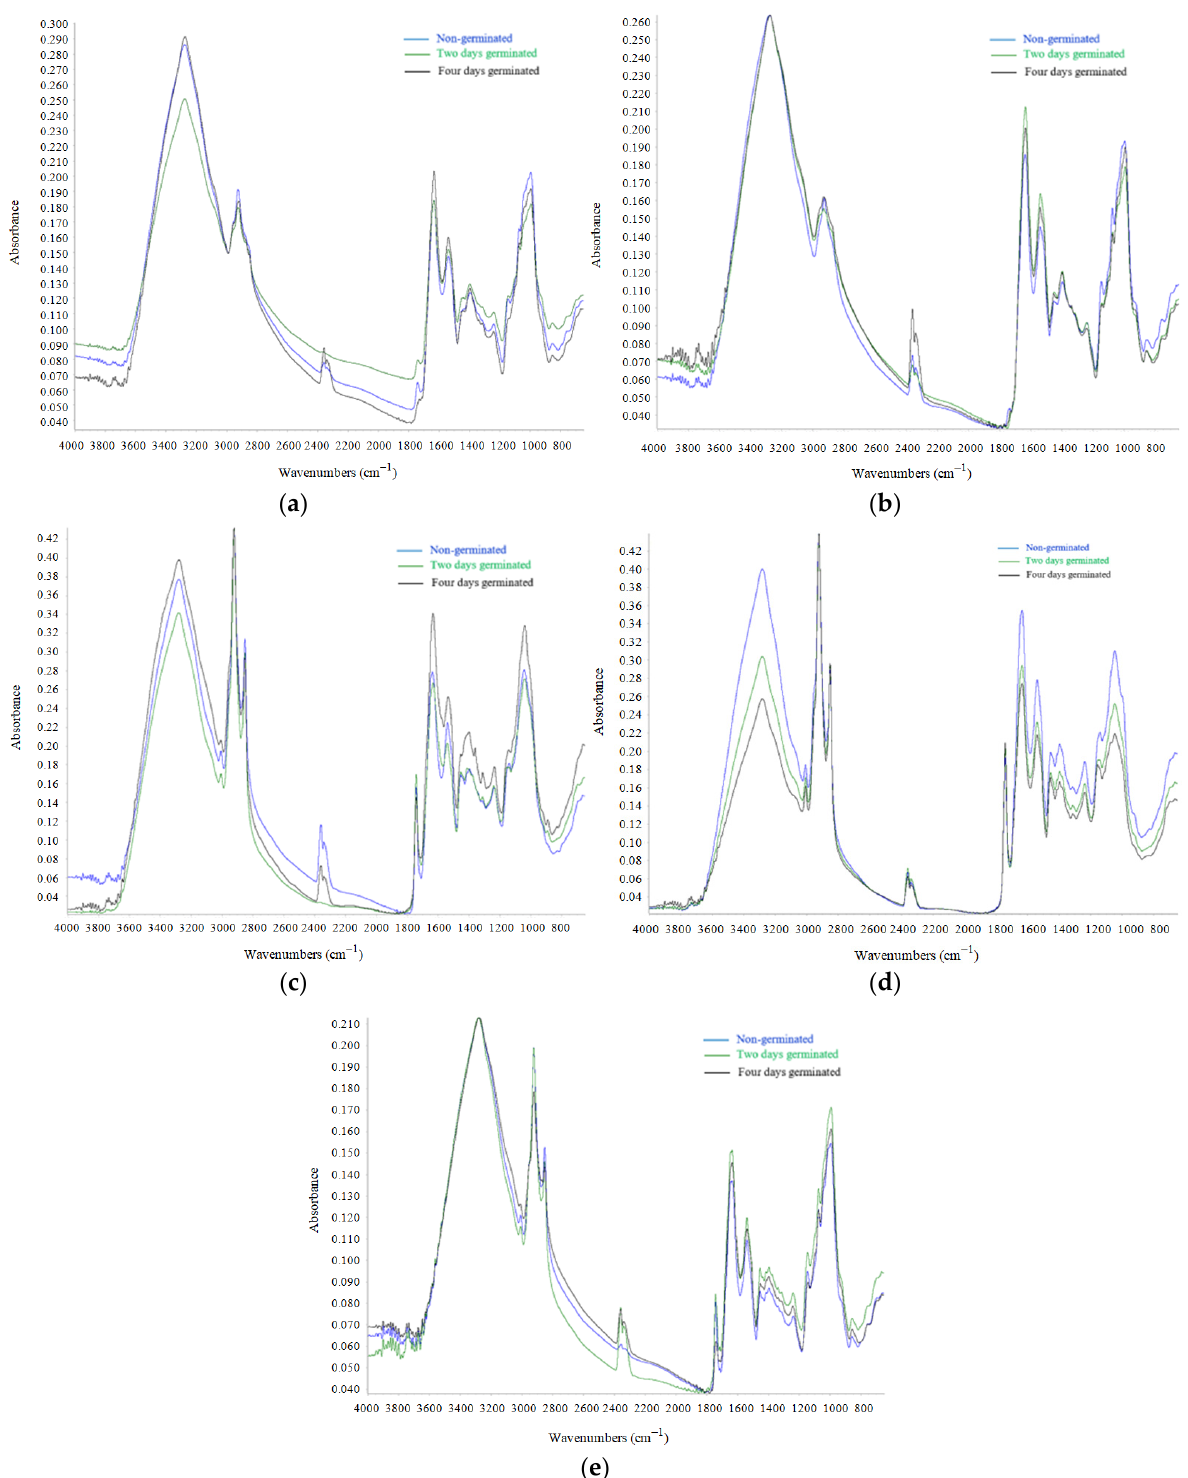
Figure 3. Fourier transform infrared spectroscopic (FT-IR) spectra of legumes during germination period: ( a ) bean; ( b ) lentil; ( c ) lupine; ( d ) soybean; ( e ) chickpea.